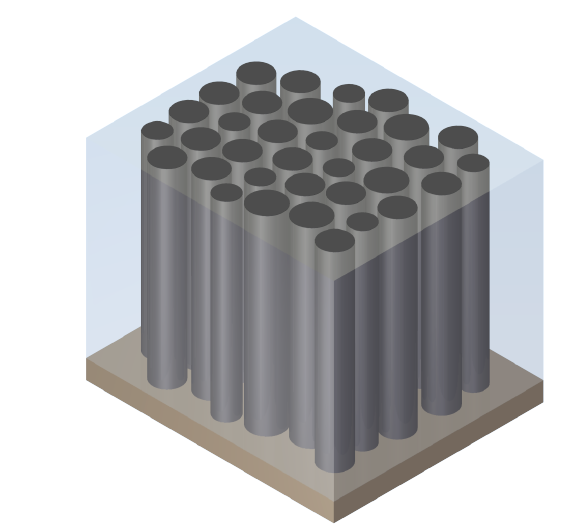
Figure 1. Simplified representation of a columnar nickel–carbon film on a substrate.